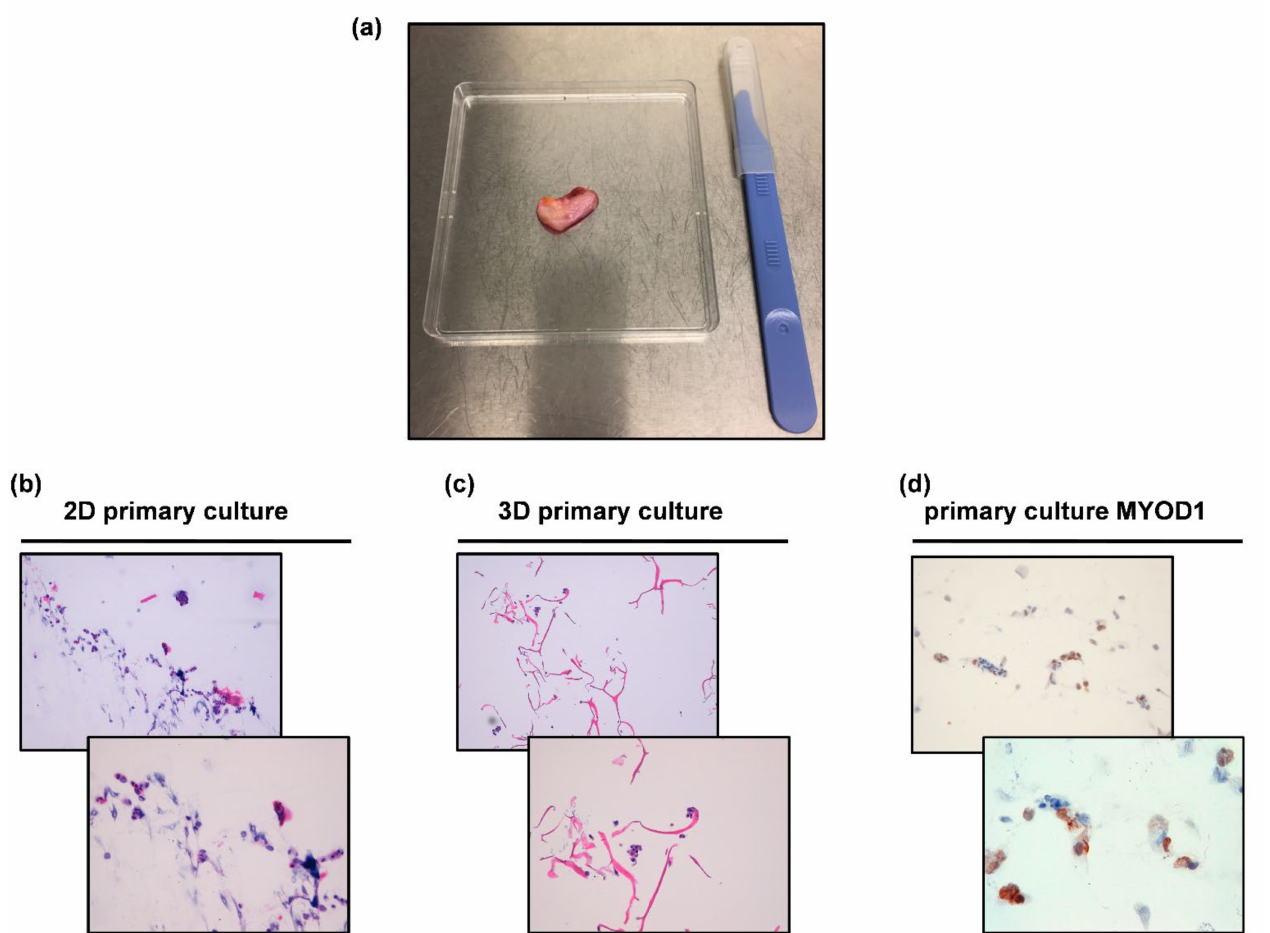
Figure 6. ( a ) Patient surgical specimen; ( b ) H&E of the 2D RMS patient-derived primary culture; ( c ) H&E of the 3D RMS patient-derived primary culture; ( d ) MYOD-1 staining by IHC in the RMS patient-derived primary cells (MYOD-1 positivity 70%). For each culture, upper panels represent 10 × magnification, lower panels represent magnification 20 ×